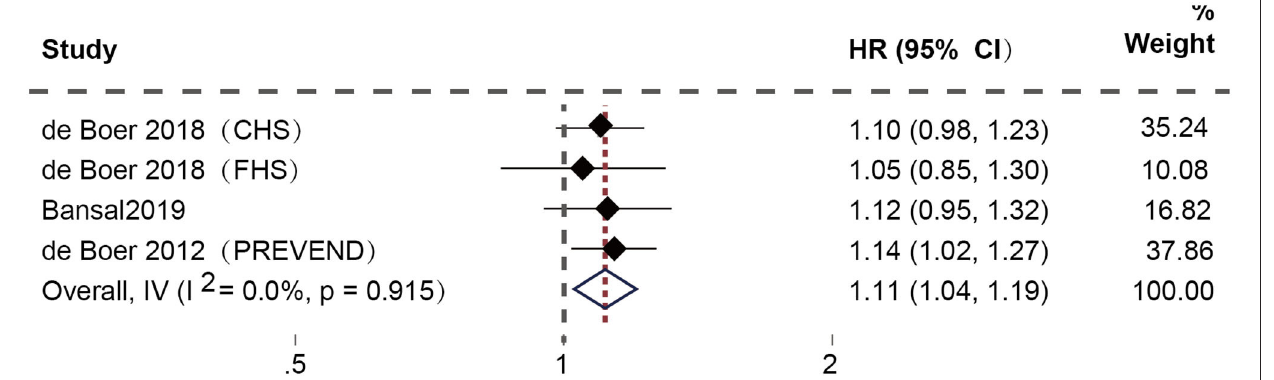
FIGURE 2 | Association between elevated plasma Gal-3 levels and new-onset